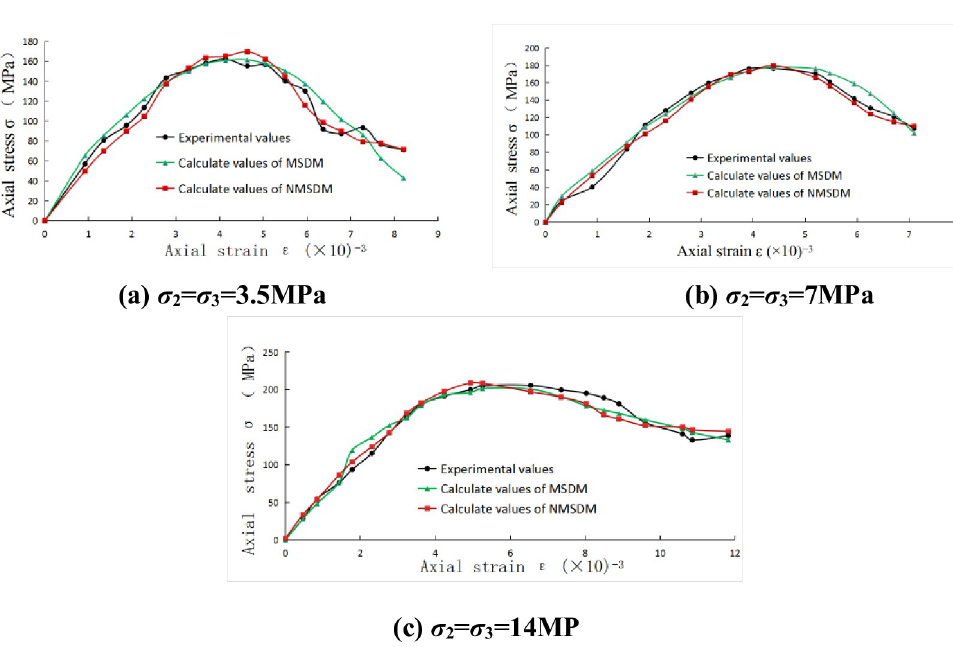
Fig 4. Comparison of experimental and calculated values for marble: (a) σ 2 = σ 3 = 3.5MPa; (b) σ 2 = σ 3 = 7MPa; (c) σ 2 = σ 3 = 14MP.